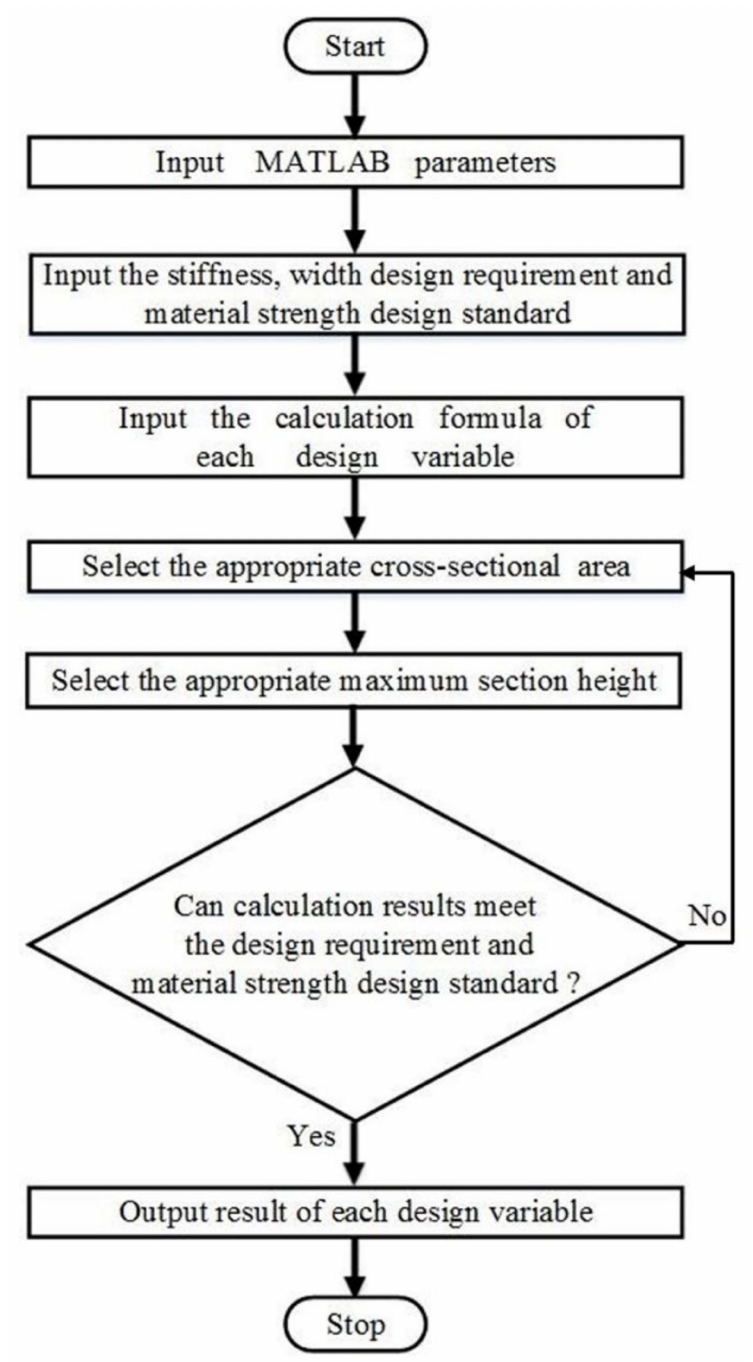
Figure 3. MATLAB calculation flow chart for structure design of the composite leaf